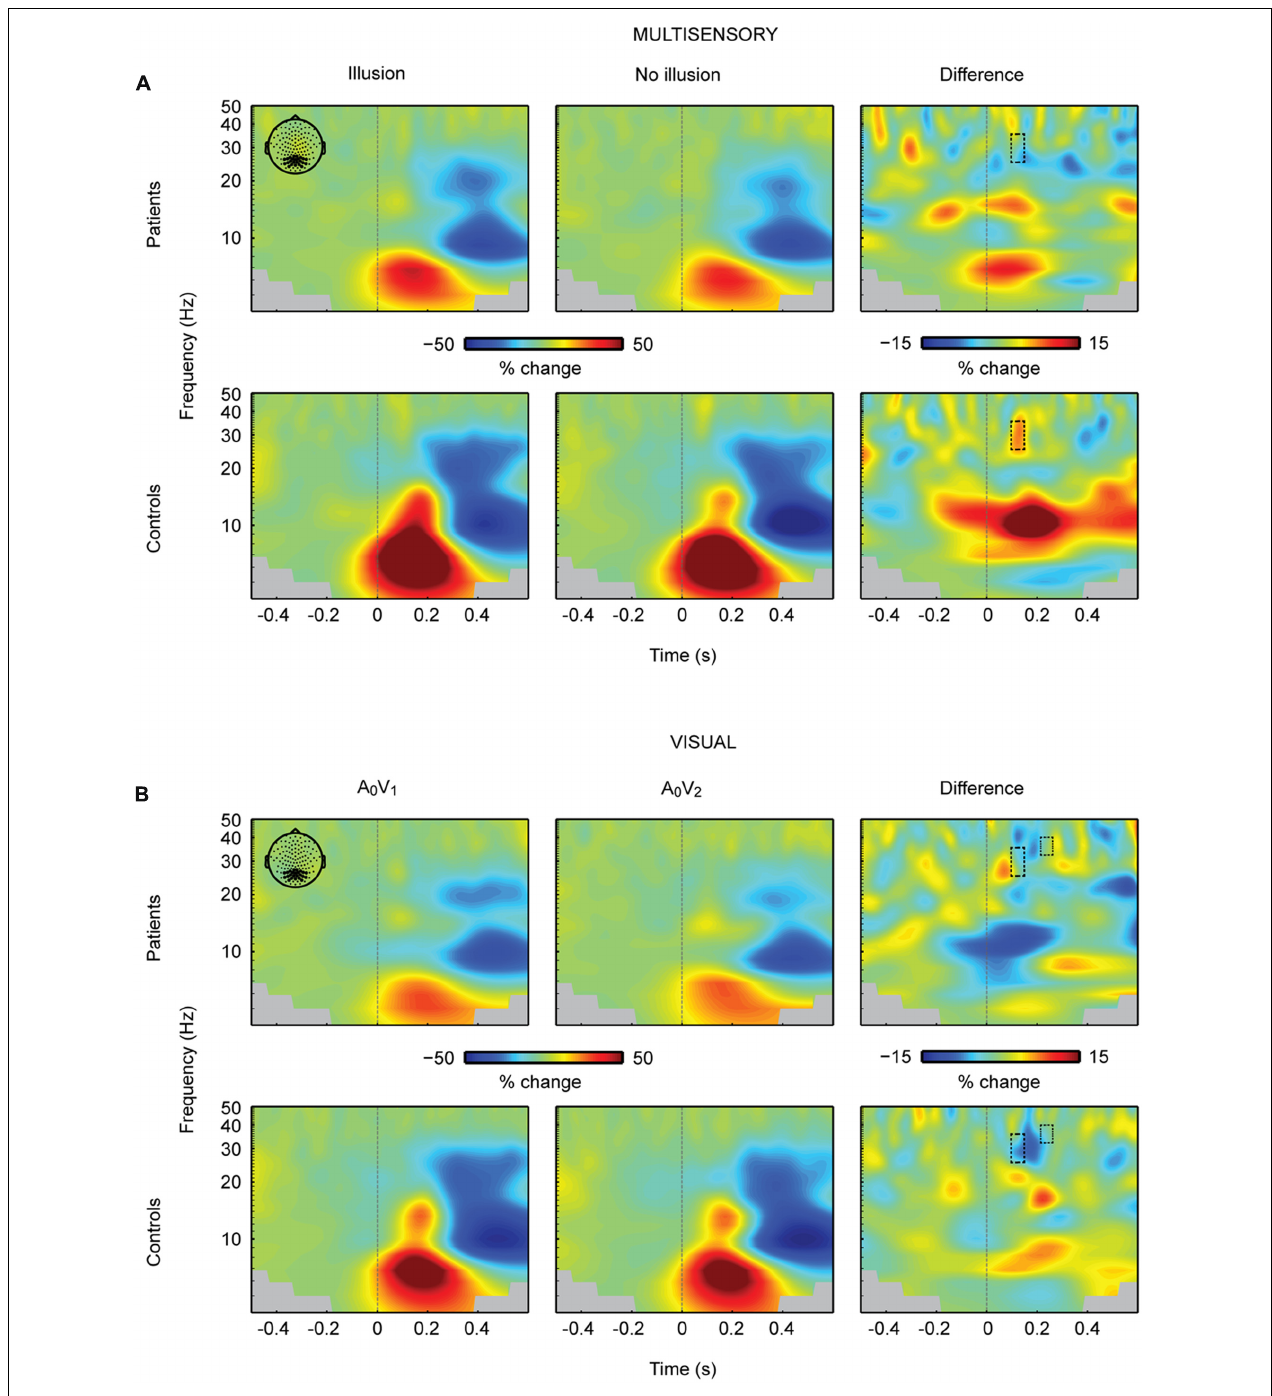
FIGURE 4 | Total oscillatory power over occipital cortex. (A) Time-frequency representations (TFRs) at occipital electrodes in response to the critical multisensory A 2 V 1 trials. In the early time-frequency window (100–150 ms, 25–35 Hz; highlighted in a box) oscillatory response patterns accompanying illusion and no-illusion trials were different between groups. In the control group, the 25–35 Hz total power was stronger in illusion compared to no-illusion trials. No such difference was found in SCZ. No effects were found in the late time-frequency window (200–240 ms, 25–35 Hz). (B) TFRs at occipital electrodes in response to unisensory visual trials. Total power in the early and late time-frequency window (each highlighted in a box) was significantly higher in the A 0 V 2 condition compared to the A 0 V 1 condition. No Group differences (i.e., SCZ vs. HC) or Group by Condition interactions were found. Time-point 0 indicates the onset of the first auditory and first visual